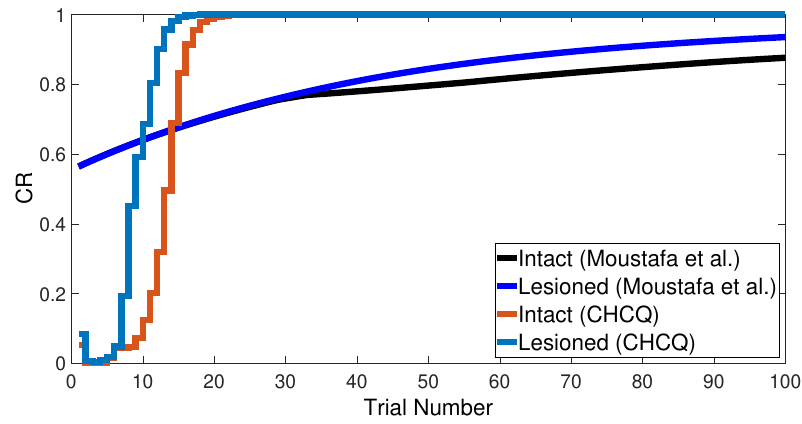
Figure 7. <A+> task for both intact and lesioned systems.